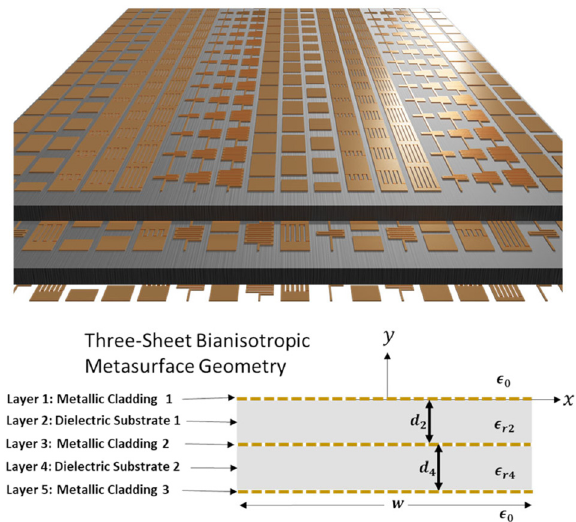
Figure 3: A three-sheet metasurface consisting of three cascaded Given the desired total fields on the left hand side of (45), the integral equation in (42) can be solved for the unknown current densities [37, 81].